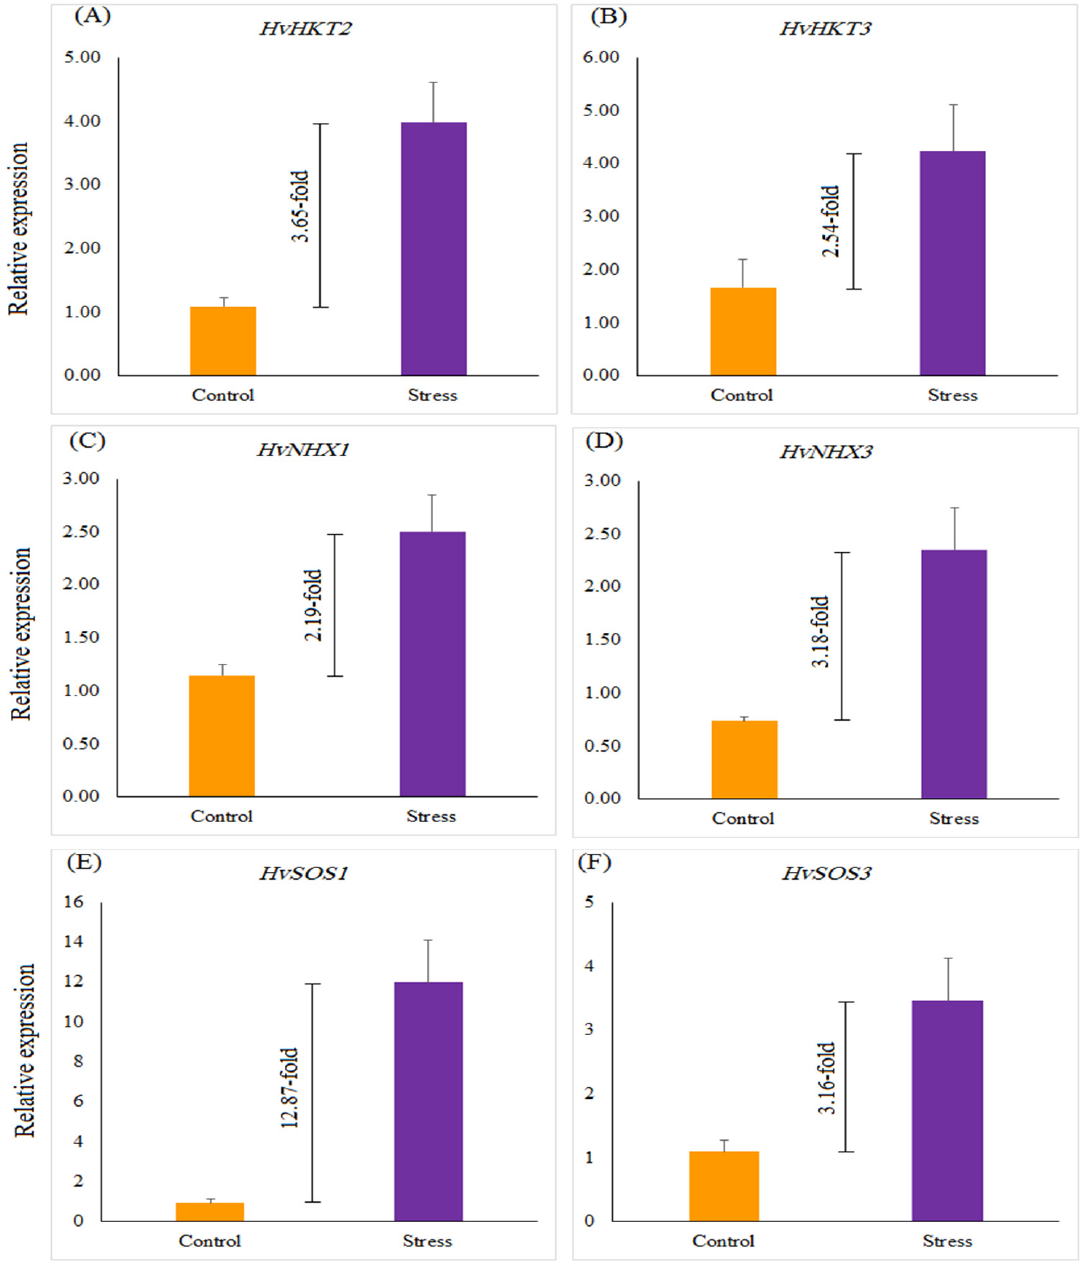
Figure 2. The relative expression of (A) HvHKT2 , (B) HvHKT3 , (C) HvNHX1 , (D) HvNHX3 , (E) HvSOS1 , and (F) HvSOS3 genes under the control and salinity stress conditions. Differences between control and stress treatments for all studied genes are significant at p < 0.01.